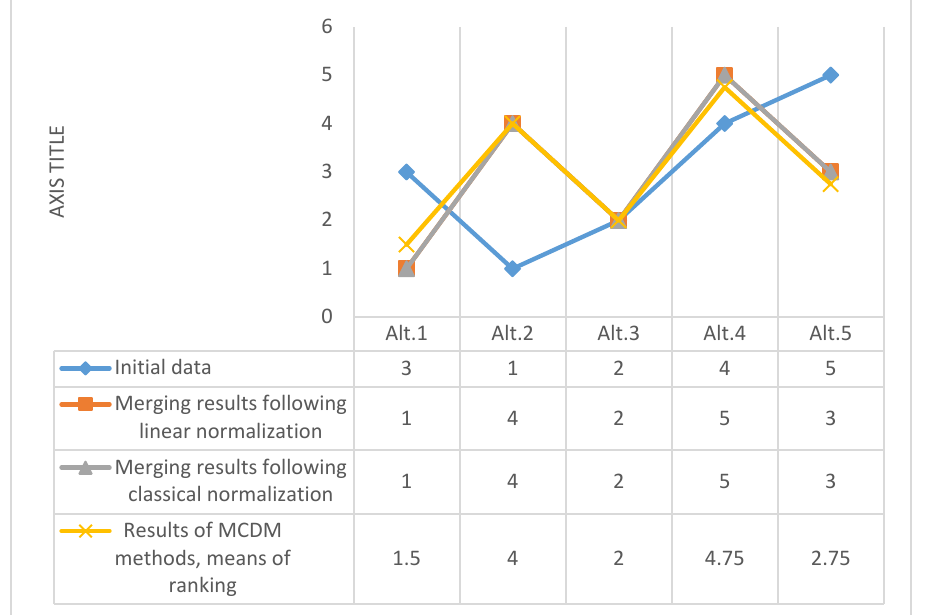
Figure 8. The results of evaluating alternatives, means of the ranked values.